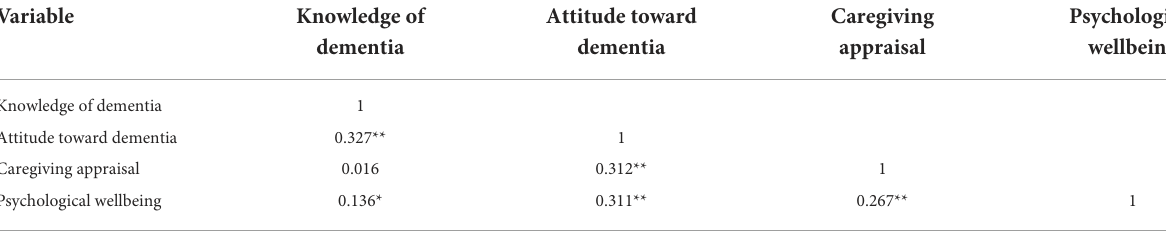
TABLE 2 Correlations between the variable total scores ( n = 223).